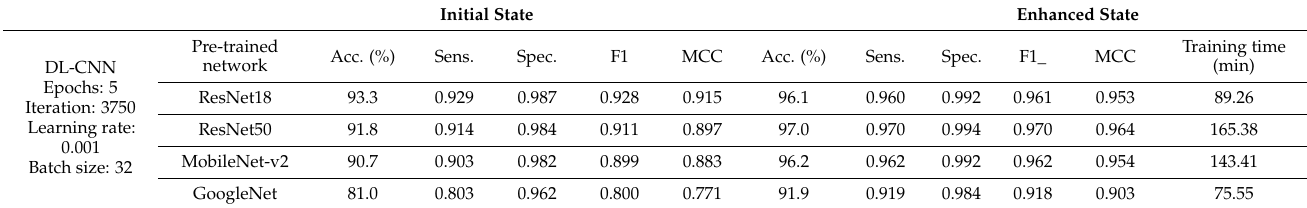
Table 5. HAR performance metrics in UCI HAR dataset.